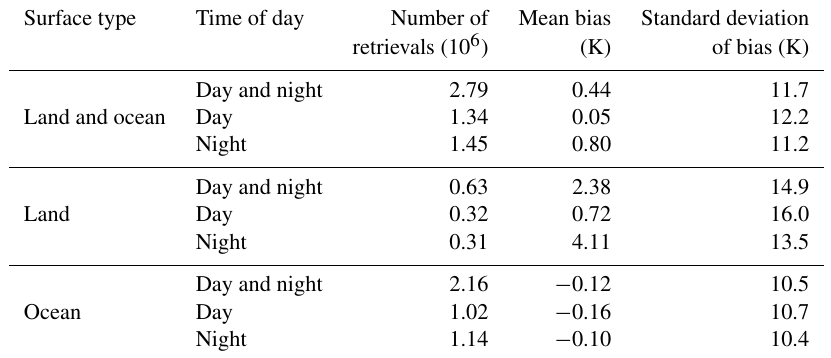
Table 2. Summary of evaluation results for the 60-ML-1 collocation criteria, showing number of collocated SEVIRI retrievals, mean bias (SEVIRI minus CALIOP CTT), and standard deviation of the bias. Statistics are reported separately for day, night, land, and ocean retrievals.